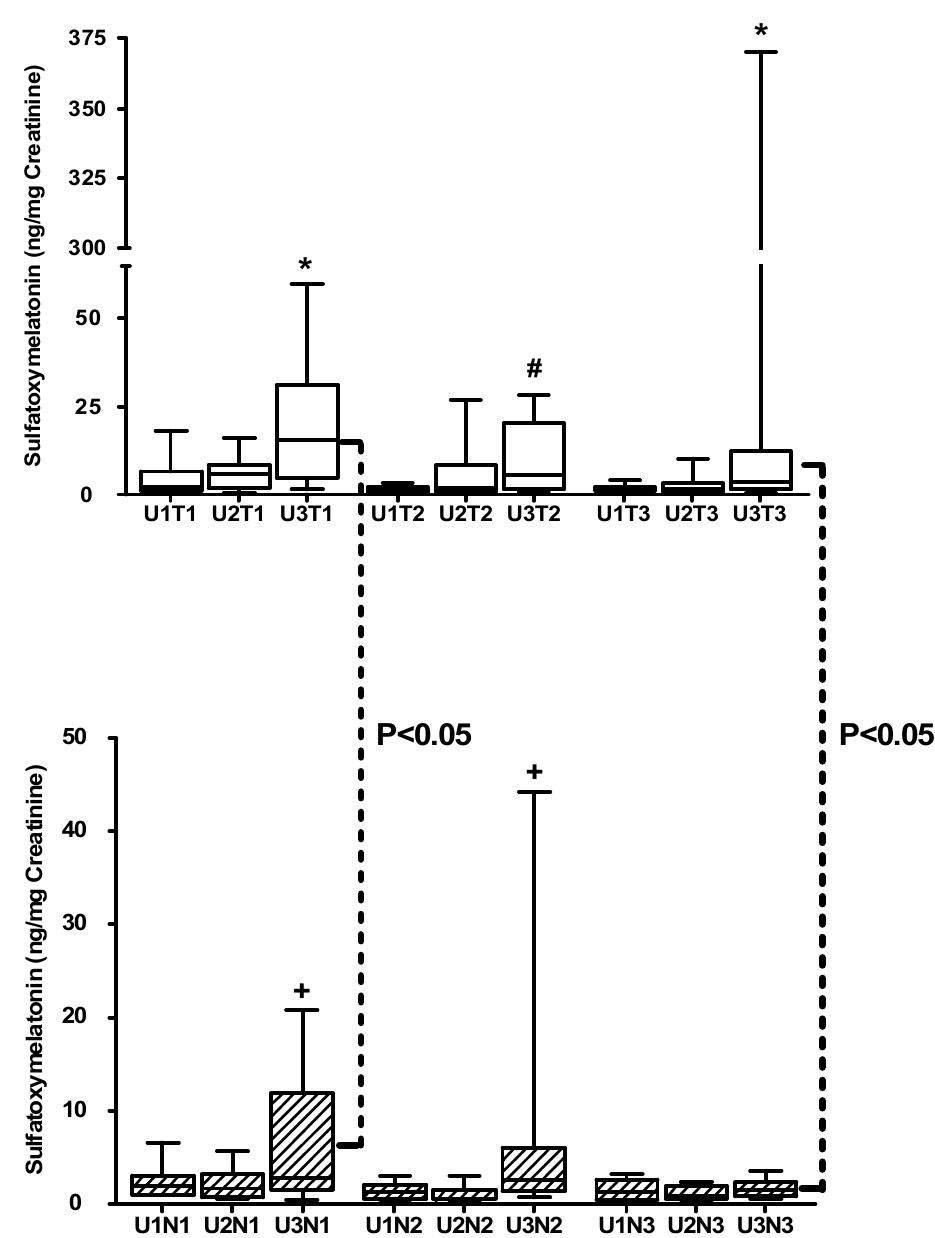
Figure 2. Time course of urinary sulphatoxymelatonin concentrations on the first, second, and third night either in a lighting environment with reduced short-wavelength components (T1, T2, and T3; upper part of Figure 2) or in an unfiltered bright light environment (N1, N2, and N3; lower part of Figure 2). Time points of specimen col- lection were 22:00 h (U1), 02:00 h (U2), and 06:00 h (U3), respectively. Data are given as median together with the 25th and the 75th quartile, whiskers represent highest and lowest values. #P <0.05 as compared to time point U1 of the respective night of the study; *P <0.05 as compared to time points U1 and U2 of the respective night of the study, +P <0.05 as compared to time point U2 of the respective night of the study. Dotted lines indicate P <0.05 when comparing U3 values in light with reduced short wavelength components with the respective time point of specimen collection in unfiltered bright